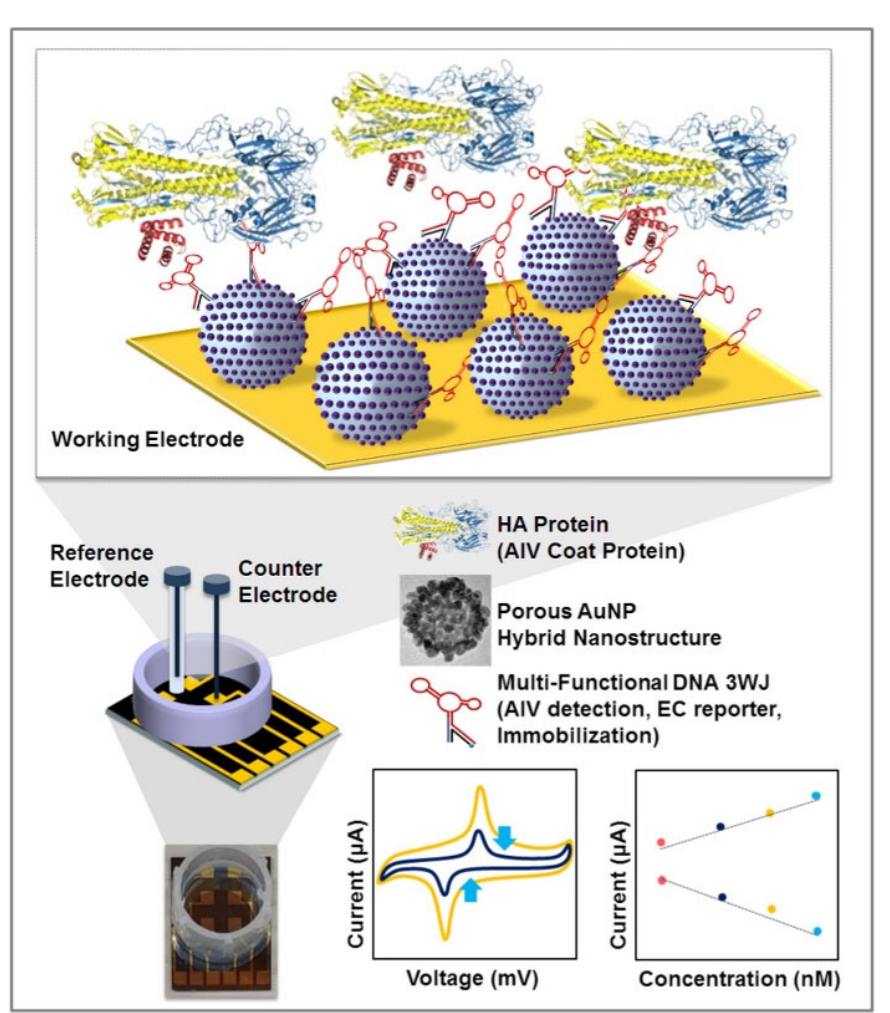
Figure 8. Schematic diagram of a biosensor for detection of avian influenza virus (Reprinted with permission from Ref. [28]. 2019, Lee et al.).